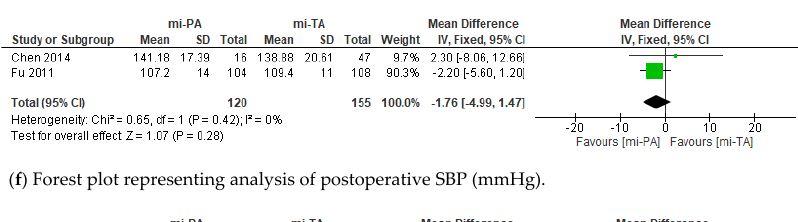
( e ) Forest plot representing analysis of patients with no ‐ standardized absent clinical success.